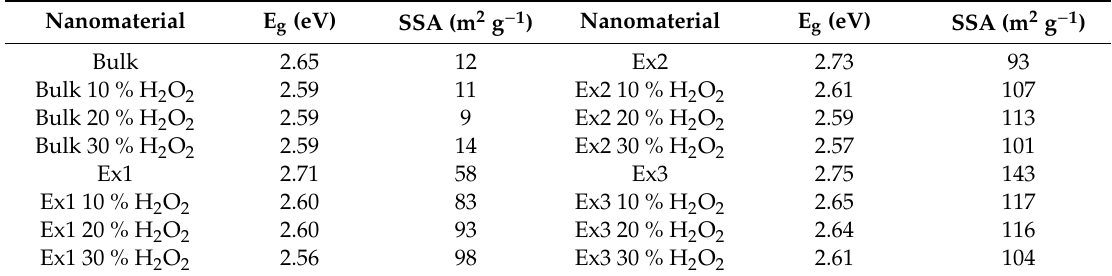
Table 2. Band gap energy and specific surface area values of GCN nanomaterials.